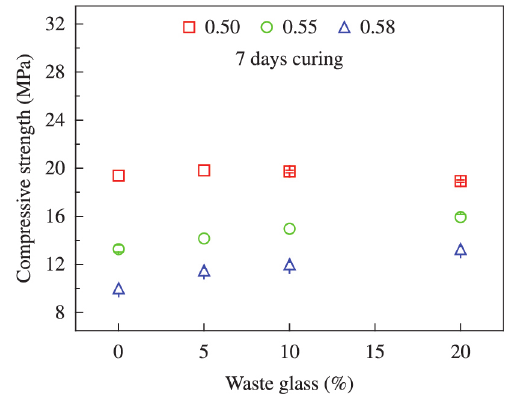
Figure 3. Compressive strength as a function of glass percentage after 7 days of curing.